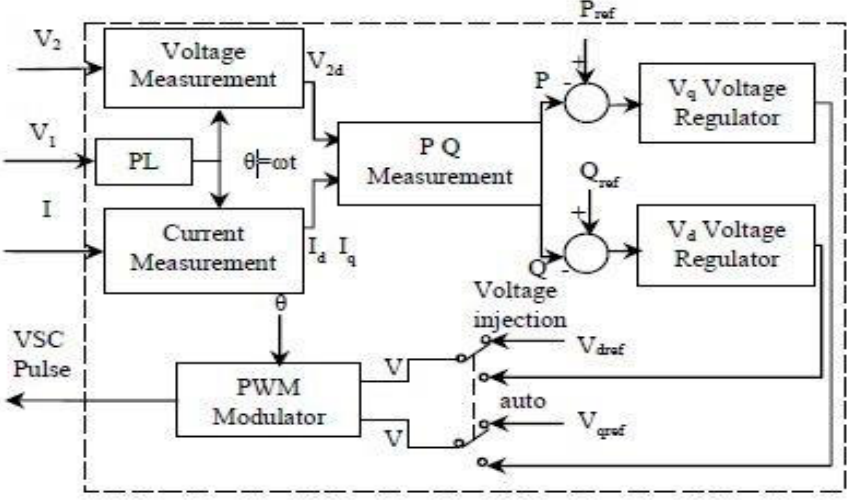
Figure 7. UPFC series converter control system simplified block diagram.